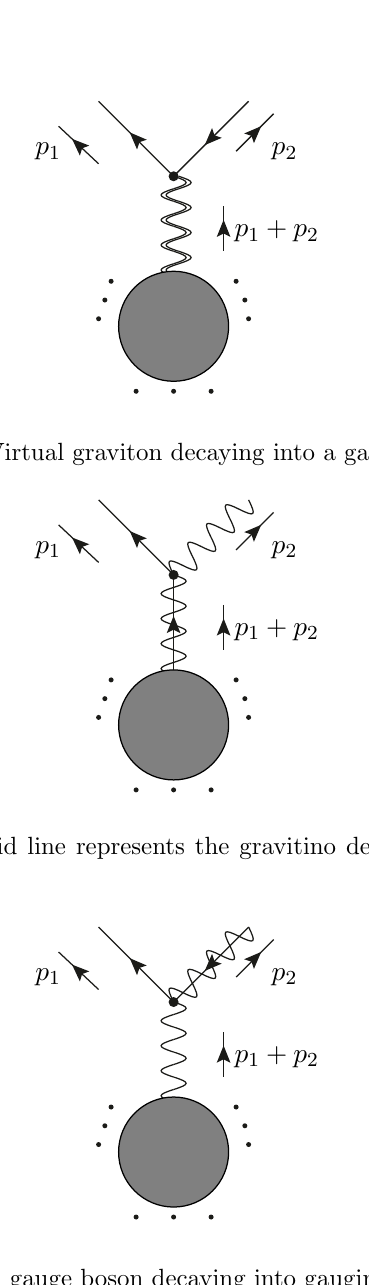
Figure 6 . Virtual gauge boson decaying into gaugino and